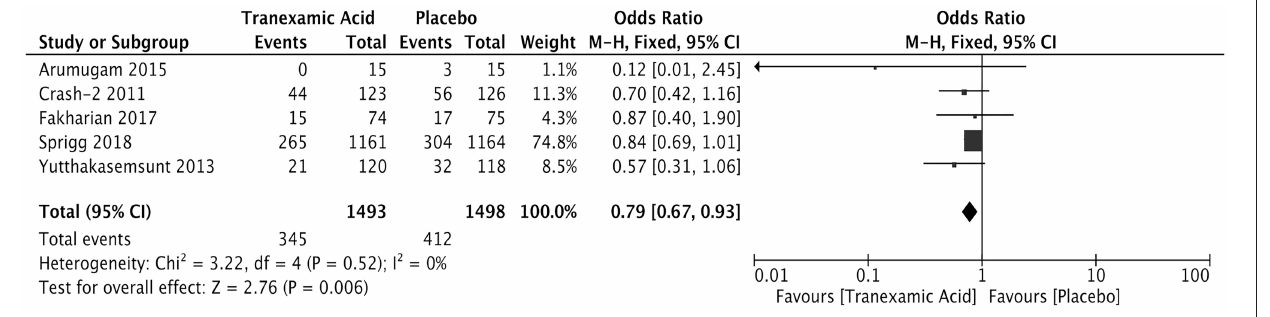
FIGURE 2 | Forest plot of the comparison between tranexamic acid and placebo treatments for hematoma expansion.